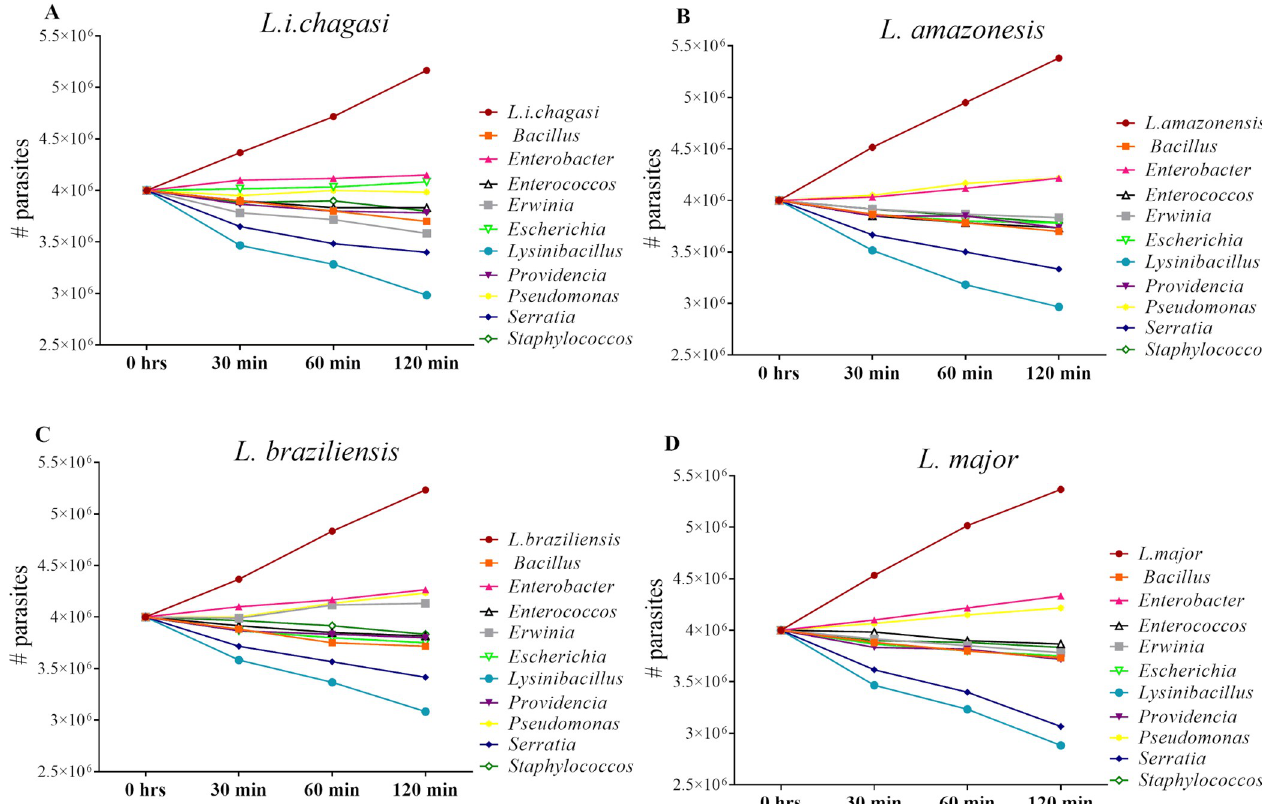
Fig 1. The short effect, in the parasite, when growth co-cultured with native bacteria. A short temporal evaluation (0 to 120 minutes) showing the activity of each one of the ten native bacteria isolated from Lu . longipalpis when co-culture with four Leishmania species: (A) L . i . chagasi , (B) L . amazonensis , (C) L . braziliensis , and (D) L . major